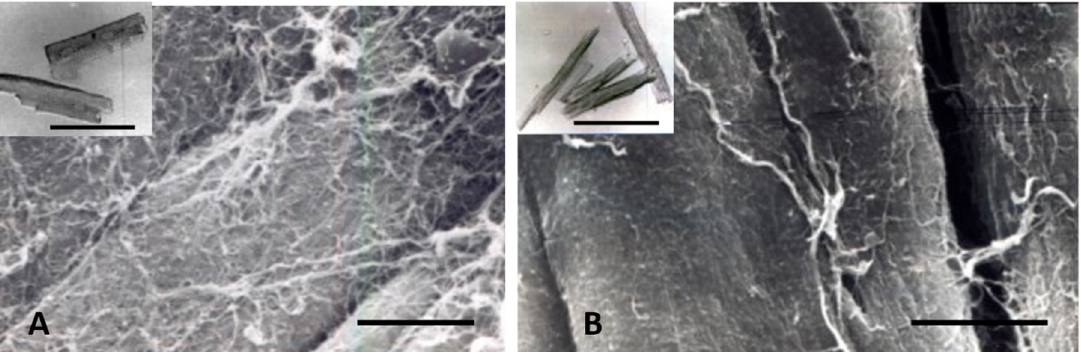
Figure 7. Scanning electron micrographs of ( A ) normal adult dog, and ( B ) dog with chronic experi- mental mitral insufficiency. Loss of interstitial connective tissue in a dog with LVH and myocardial failure. Bar = 10 µm in both. Insets: isolated myocytes from normal and LV failure dog. Myocytes are longer and thinner in mitral regurgitation with failure. Bar = 100 µm in both.